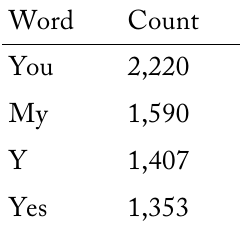
Table 7: Top ranking words containing